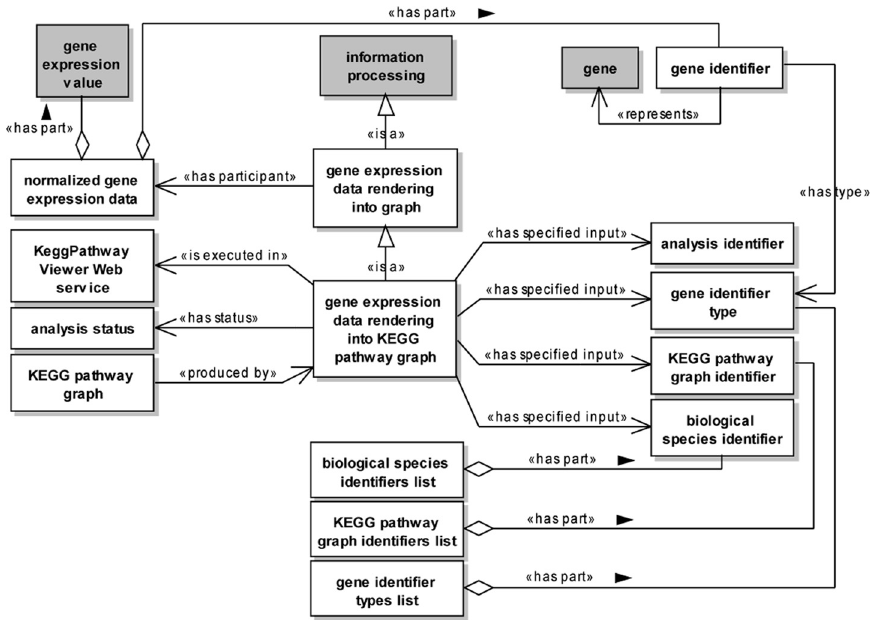
Fig 5. UML class diagram representing an excerpt of the GEXPASO ontology. A named rectangle represents a class. Classes in white represent concepts introduced in the GEXPASO ontology, while classes in gray represent concepts reused from other ontologies. A solid line with a stick arrowhead at its end represents a relationship between two concepts (UML association). A solid line with a hollow diamond at its end represents an aggregation relationship (UML aggregation). Finally, a solid line with an hollow triangle as an arrowhead represents a generalization relationship (UML generalization).